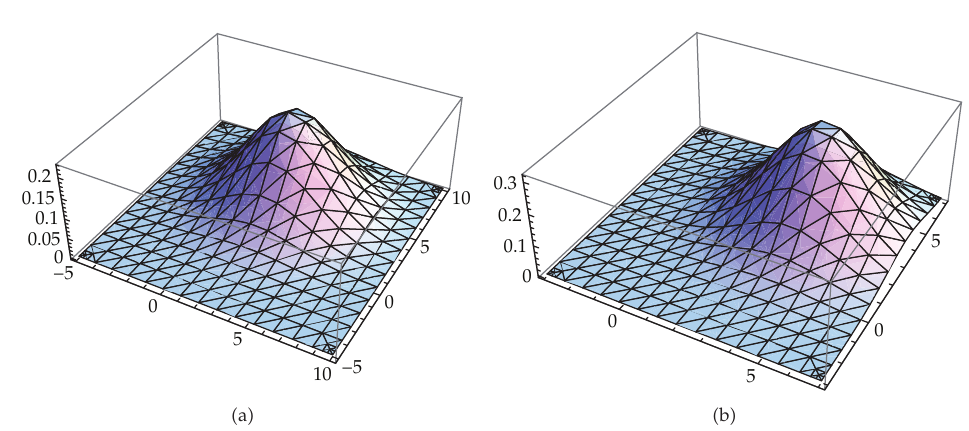
Figure 3: Di ff erent parameters in EC models also are subject to density function requirements. (cid:2) a